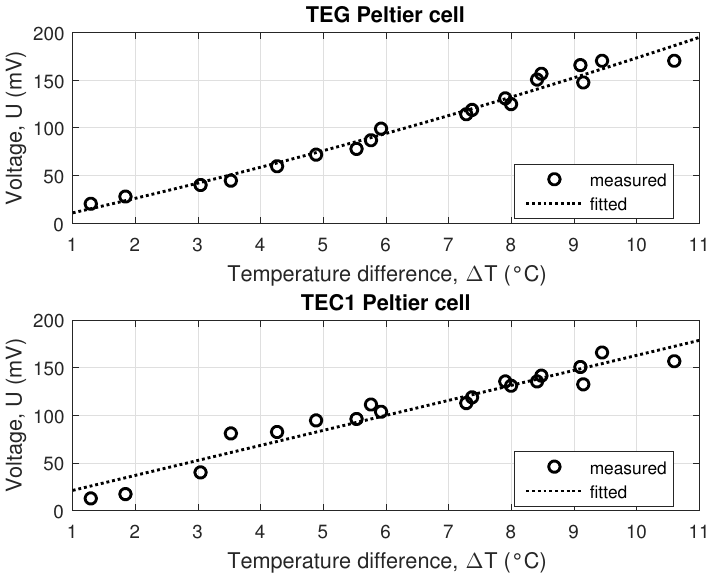
Figure 11. Dependence of the temperature difference on voltage in TEG and TEC1 Peltier cells for experiments simulating the real conditions at the mining